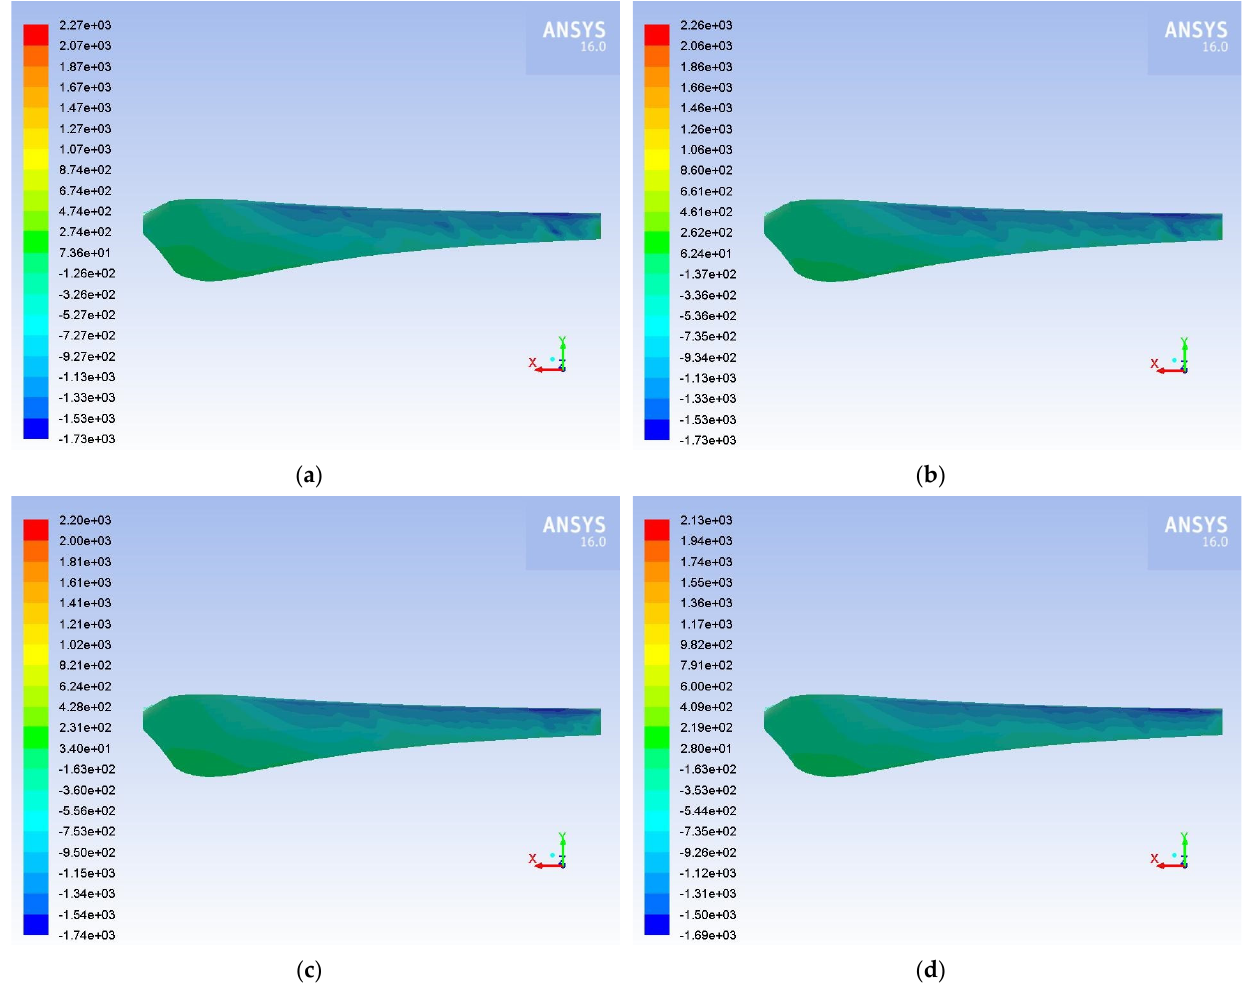
Figure 8. Static pressure contours at the blade’s suction side and at wind speed of 10 m·s − 1 . ( a ) Q =